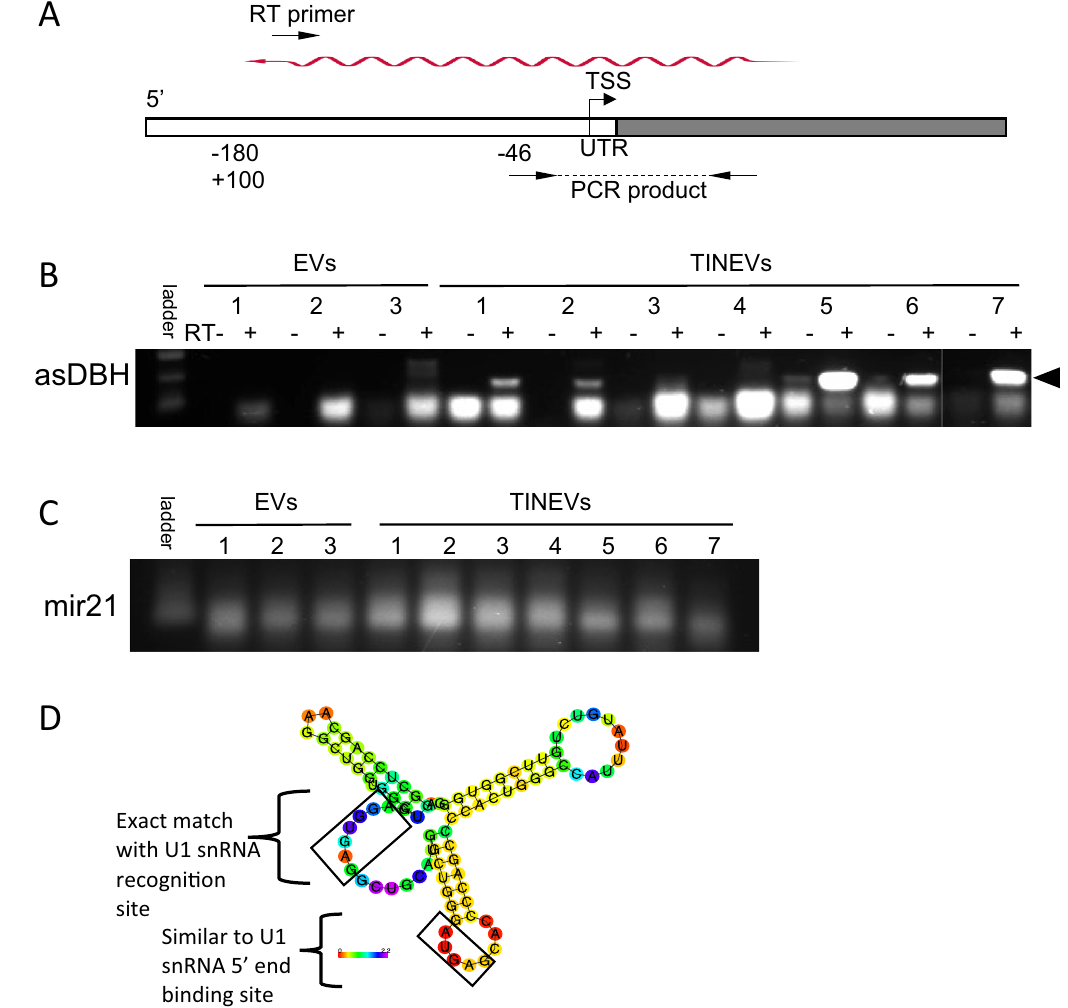
Figure 6. Toxoplasma-induced neuronal extracellular vesicles (TINEV) contain an antisense DBH lncRNA. (A) Schematic representation of the DBH gene. The transcription start site (TSS) and untranslated region are highlighted with the binding sites of the directional RT and PCR primers used to detect the antisense lncRNA. The antisense lncRNA is depicted as the undulating arrow. (B) Detection of asDBH by directional RT-PCR. TINEVs purified from repeated experiments (n = 7) and EVs from uninfected cultures (n = 3) resolved by gel electrophoresis with 1 kb Plus DNA Ladder (NEB). The product (arrowhead) is indicated (verified by sequencing). Alternating lanes are control reactions lacking reverse transcriptase. The full gel photo is shown in Fig. S10. (C) An agarose gel of RT-PCR of miR-21 from all samples as a control for RNA quality. (D) A drawing of the minimum free energy secondary structure prediction of asDBH using RNAfold with the base pair probabilities colored 82 and conserved binding sites for U1 snRNA identified as described in Yin et al. 54